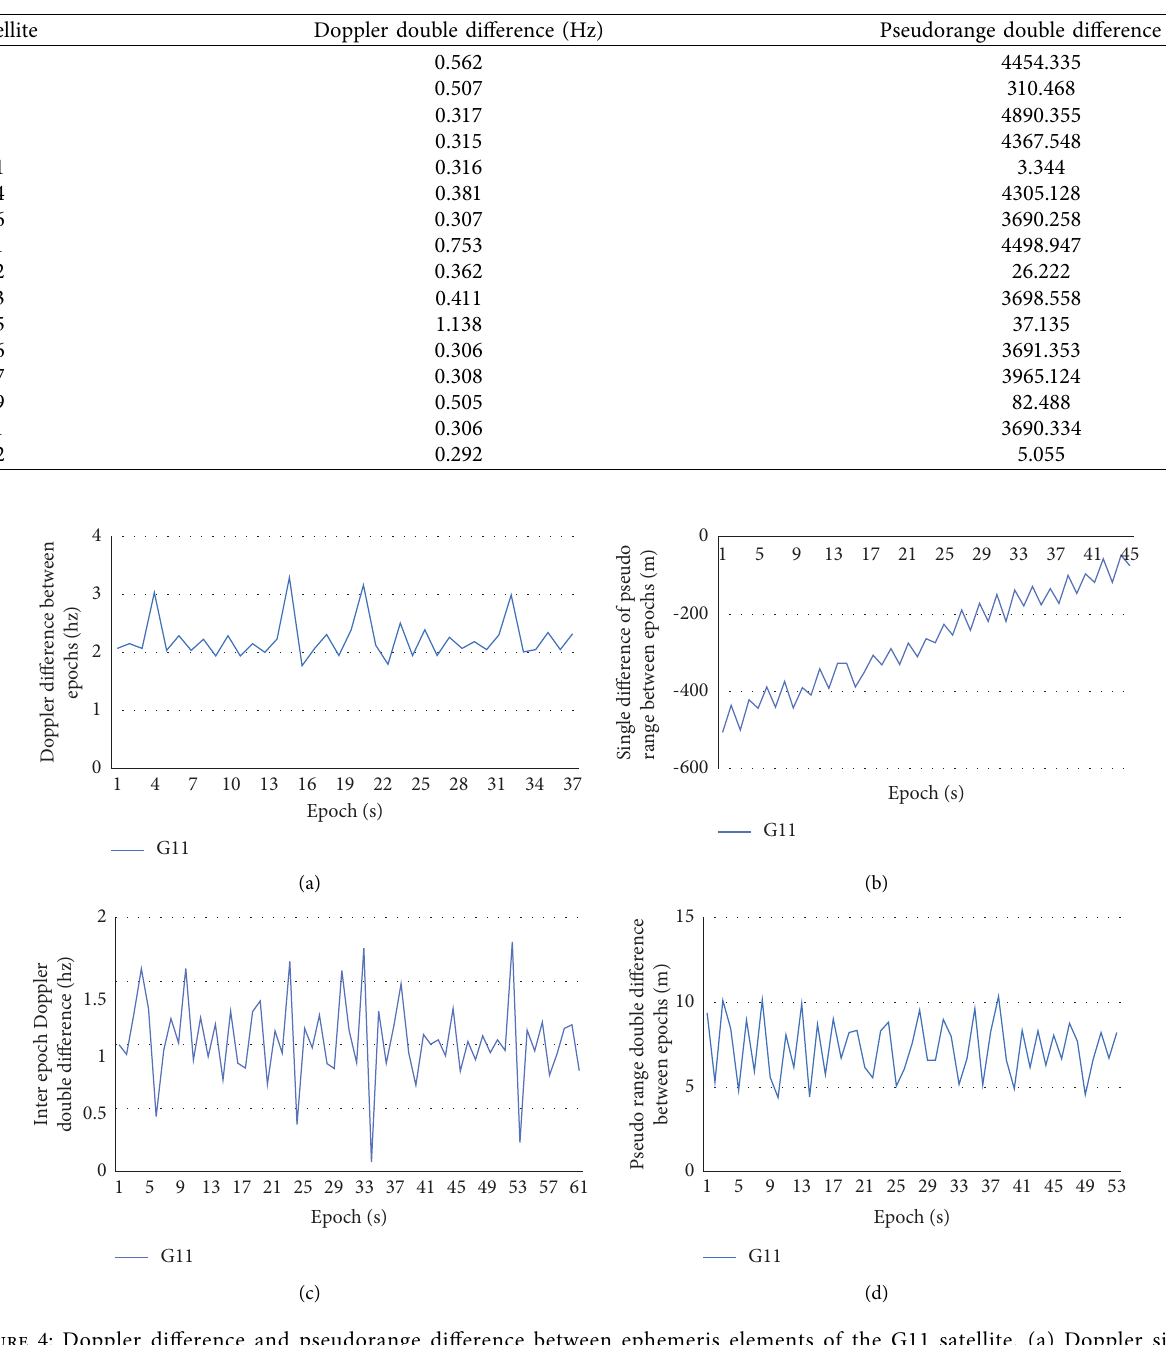
Table 2: 5G smart communication base station observation double diference error statistics.